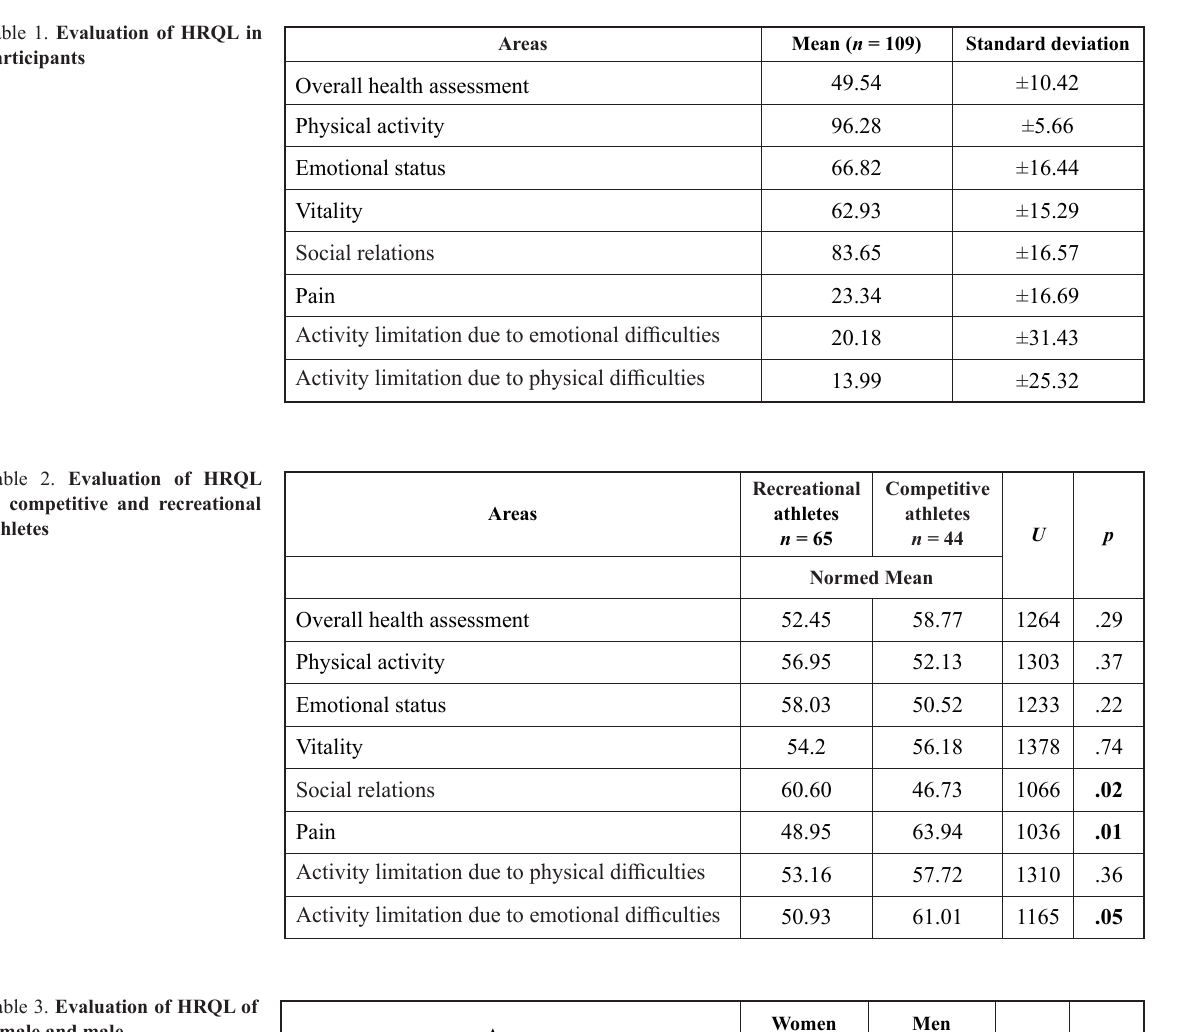
Table 3. Evaluation of HRQL of female and male